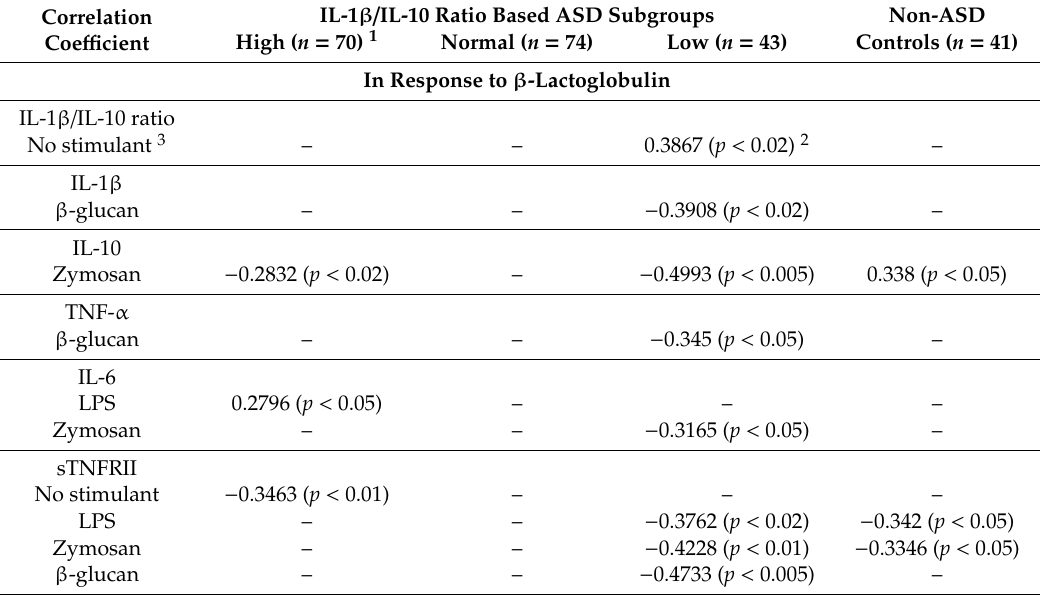
Table 8. Correlation between IL-12 production by PBMCs and monocyte cytokine